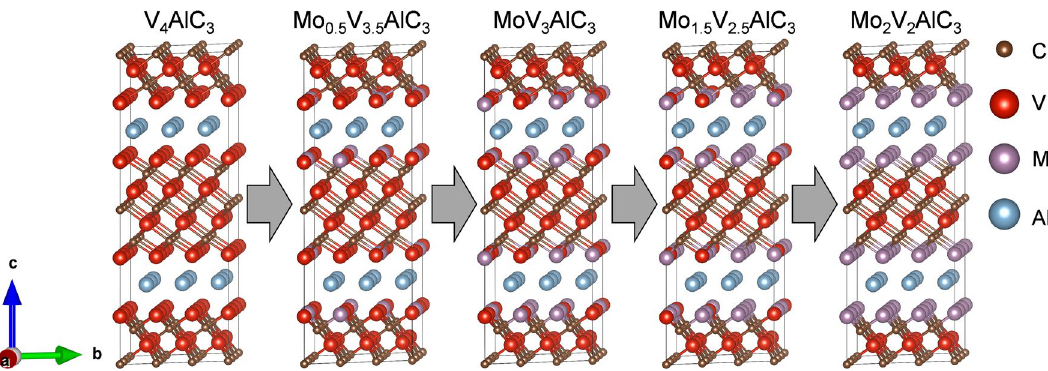
Figure 4. Atomistic models for the five stable MAX alloys according to the DFE formalism. We show the models as the Mo content increases from left to